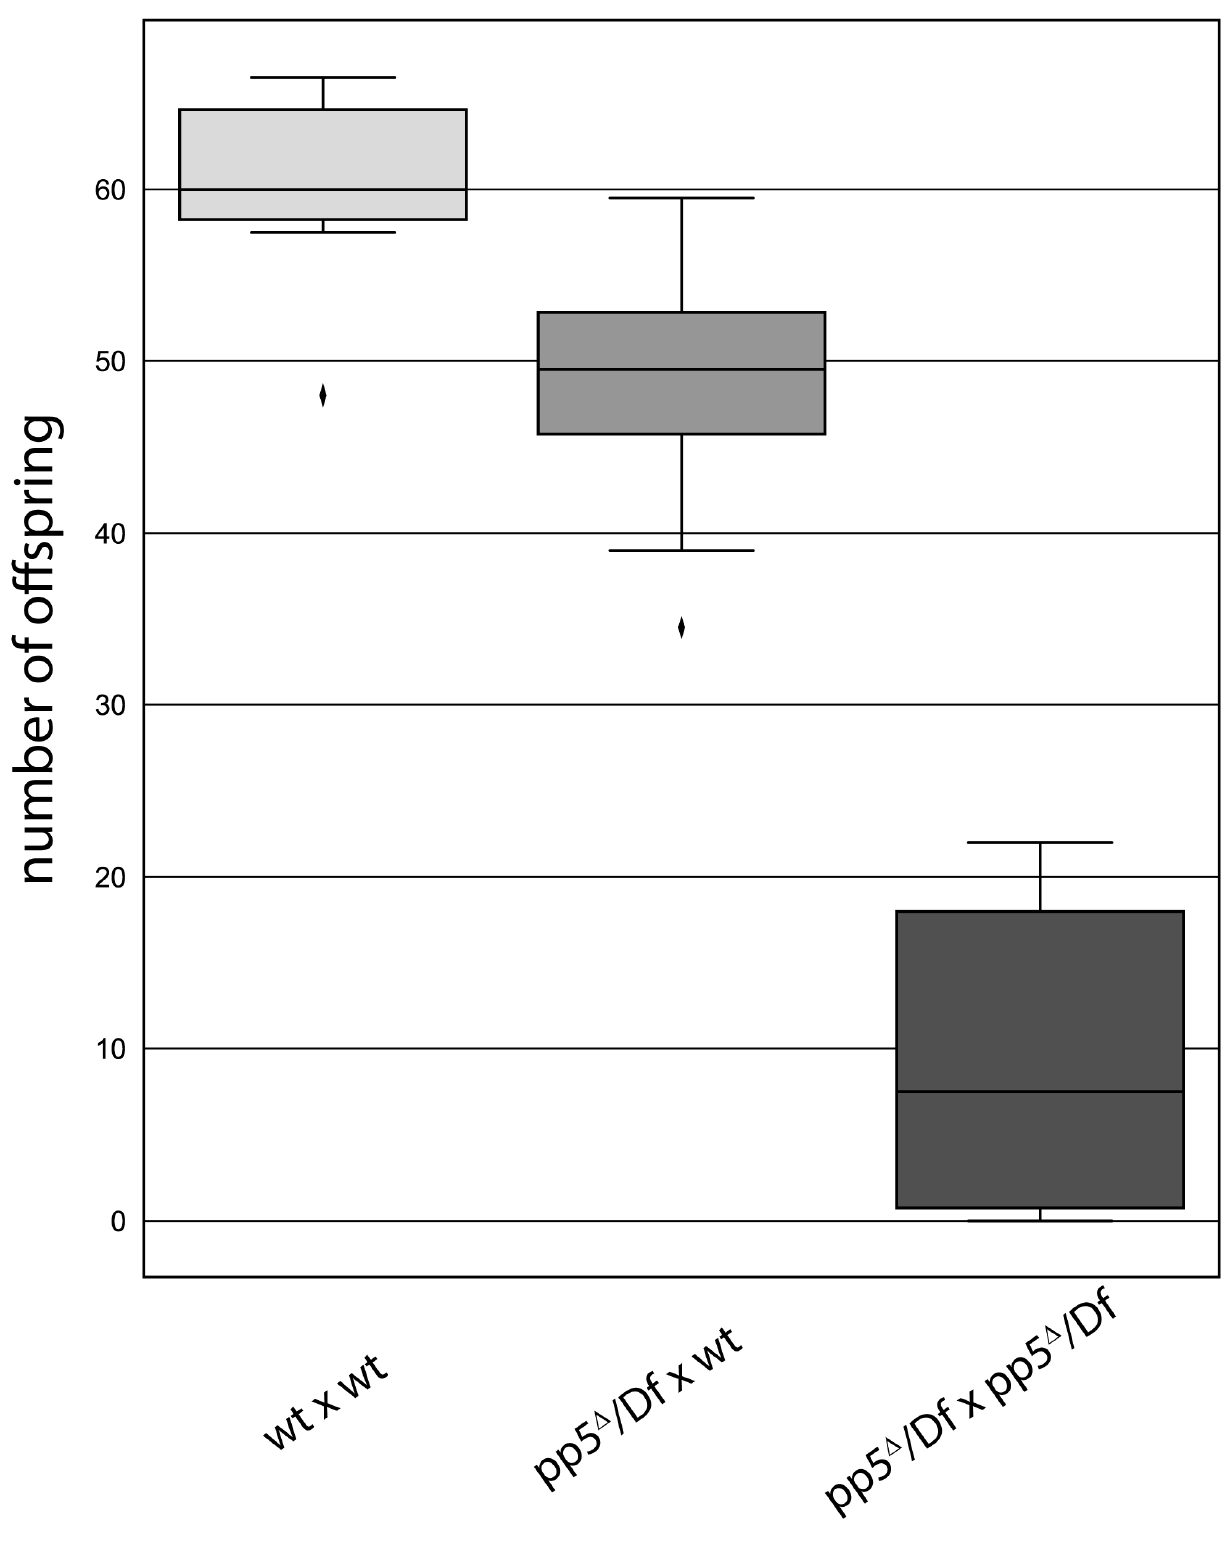
Figure 8. pp5 deletion is viable, but leads to a reduced fertility in Drosophila . Wild type (wt) or pp5 ∆ /Df females were tested by crossing to wild type (first and second bars, p<0.01) or pp5 ∆ /Df males (third bar, p<0.001). We found a significant decrease in progeny number when pp5 ∆ /Df siblings were crossed, suggesting the role of PP5 in the early development of fruit flies. Significance was determined by Welch’s